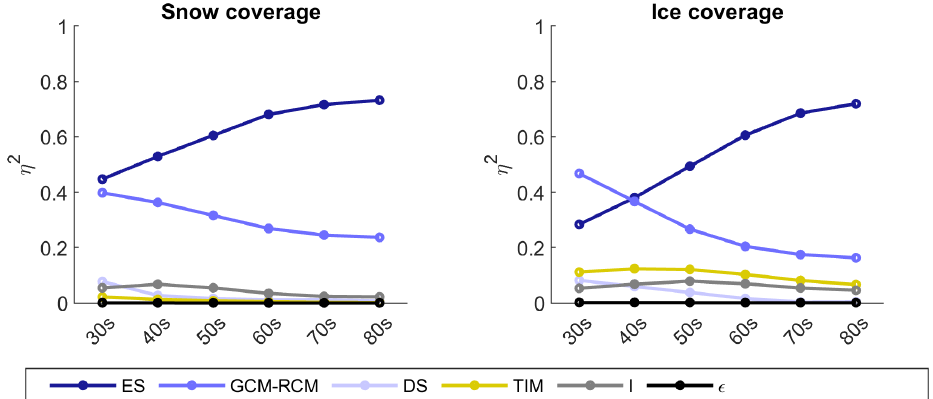
Figure 10. Effect size ( η 2 ) of main effects (ES, GCM–RCM, DS and TIM), interactions (I), and remaining error ( (cid:15) ) on projected changes in snow and ice coverage calculated using ANOVA for the six 21st century time slices. Note that the ROR main effect is not included here as it does not influence cryospheric processes in the GHM.